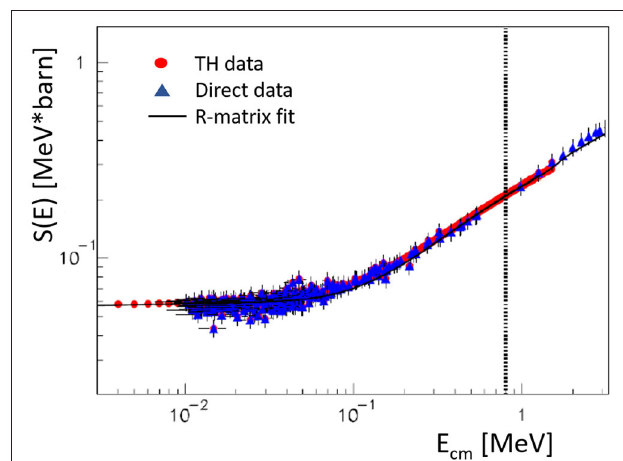
FIGURE 1 | Bare nucleus S-factor for the 2 H(d,p) 3 H reaction obtained after putting together direct data (blue filled triangles) and with the THM ones (red filled circles) taken from ( Tumino et al., 2014). The solid line is the R-matrix fit to direct and indirect sets, as in section 3.1. The resulting parameters of the equivalent fit (polynomial plus Breit-Wigner) are listed in Table 1 . Energy range of interest for BBN is marked by the vertical dotted line. The figure is adapted from Pizzone et al. (2014).